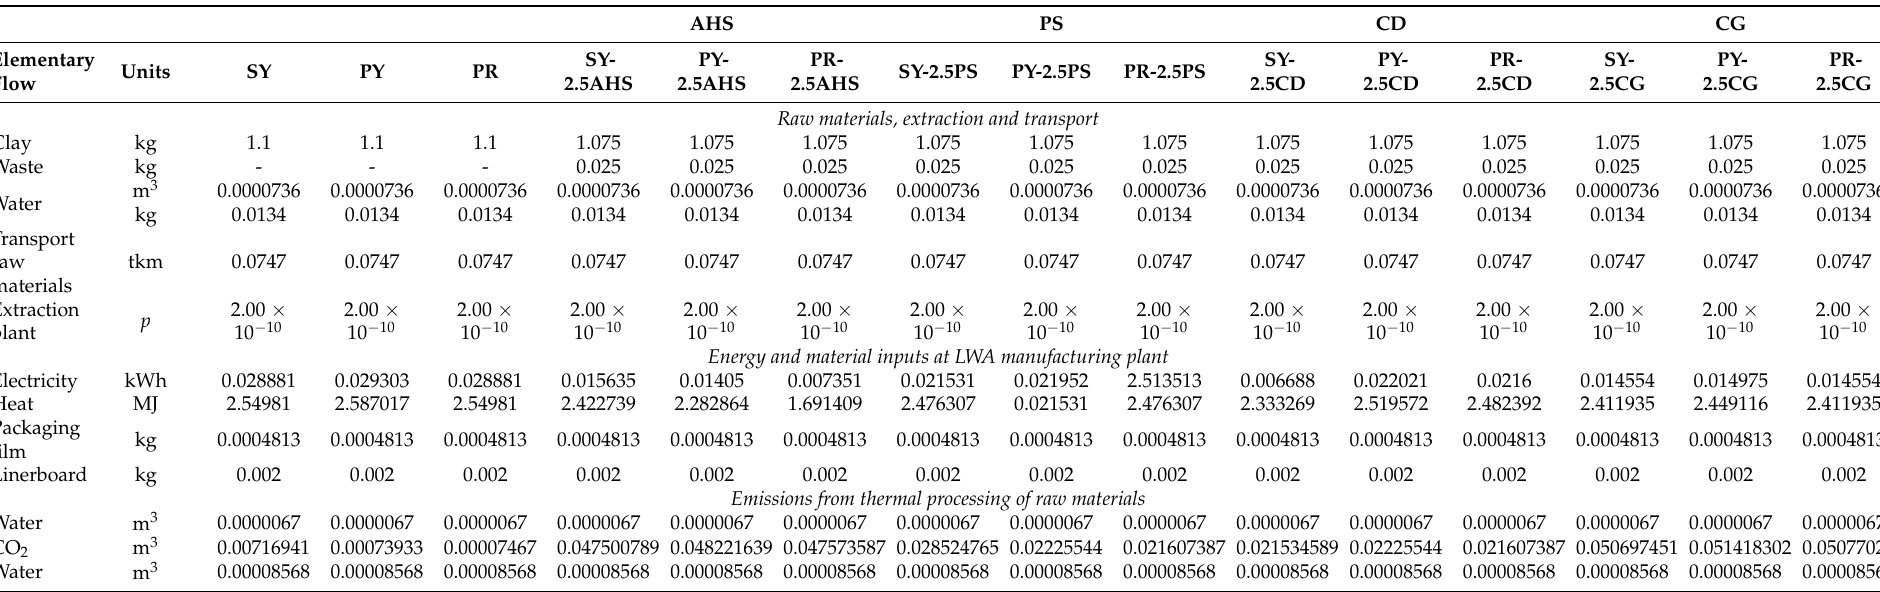
Table 3. Most relevant inventory data associated with the production of 1 kg of lightweight aggregates for the different phases analyzed: raw materials, extraction, transport and manufacture. AHS PS CD